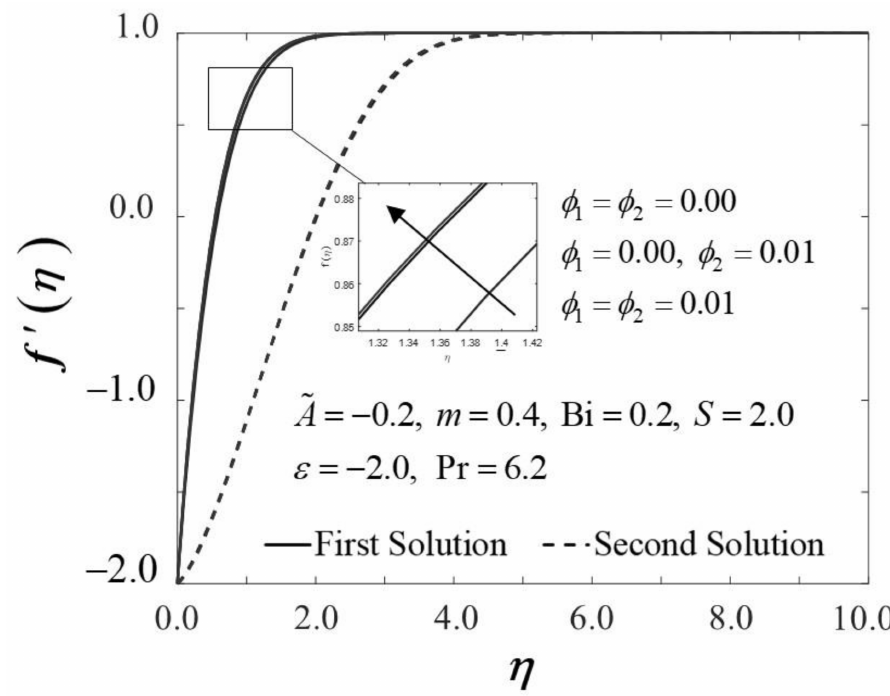
Figure 4. Trend of f (cid:48) ( η ) with η and assorted φ .